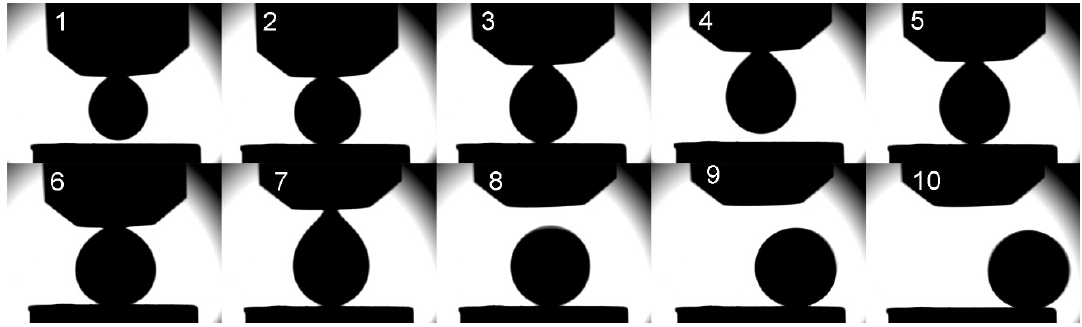
Figure 5. Sequence of photos of the sessile drop experiment on Al 2 O 3 -C substrate with capillary purification of AlSi7Mg alloy—Measurement 2.